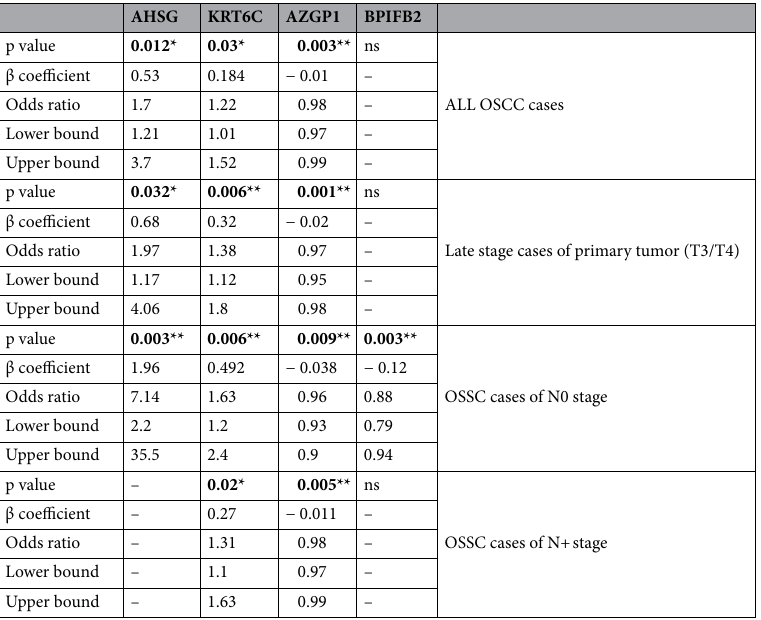
Table 3. Multiple regression analysis of the significant proteins for OSCC cases (All, Late T stage, N0 and N+). Ns non-significant. Bold values indicate statistical significance (p <